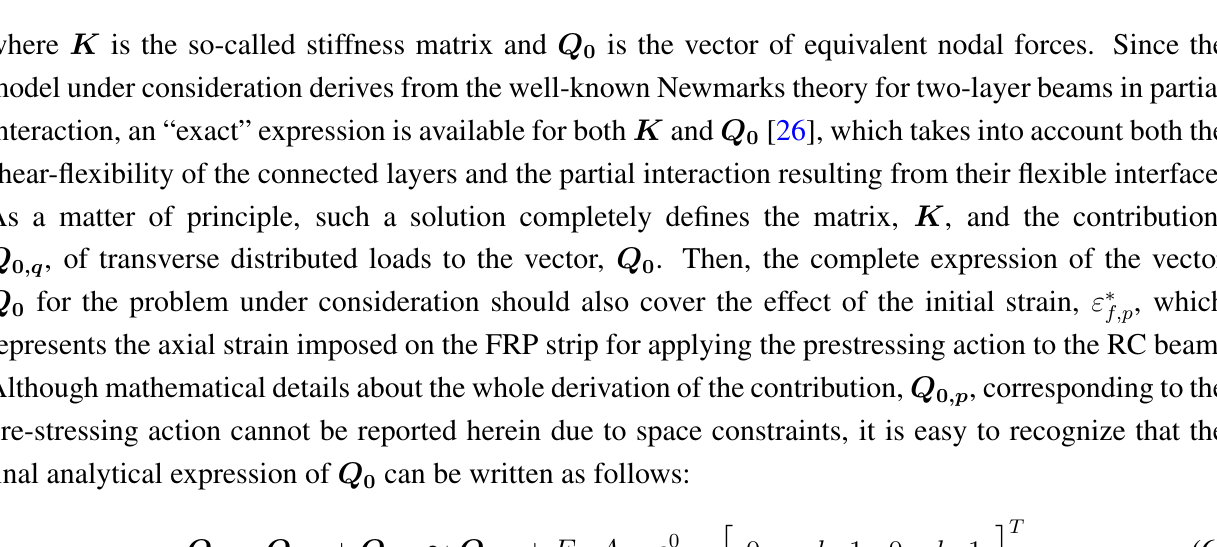
The force and displacement vectors are related by means of the following usual